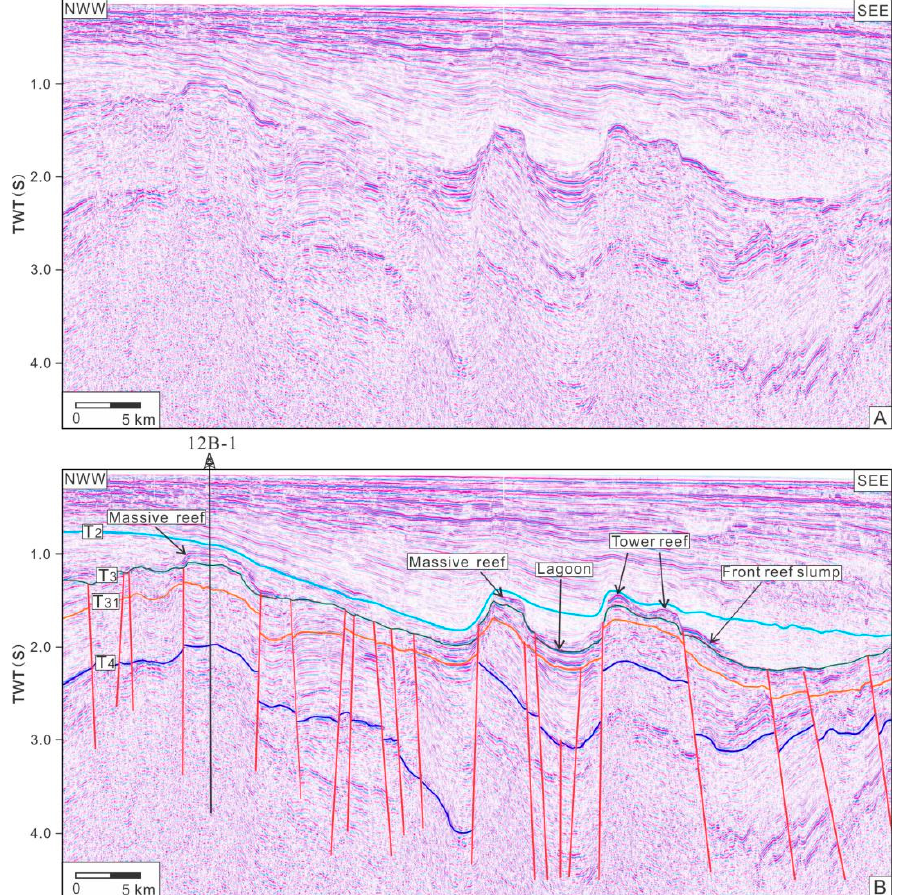
Figure 9. ( A ) Seismic profile of RCPs in south of Wan’an Basin. ( B ) Seismic profile of RCPs in south of Wan’an Basin with annotation. Profile location is shown in Figure 2d.